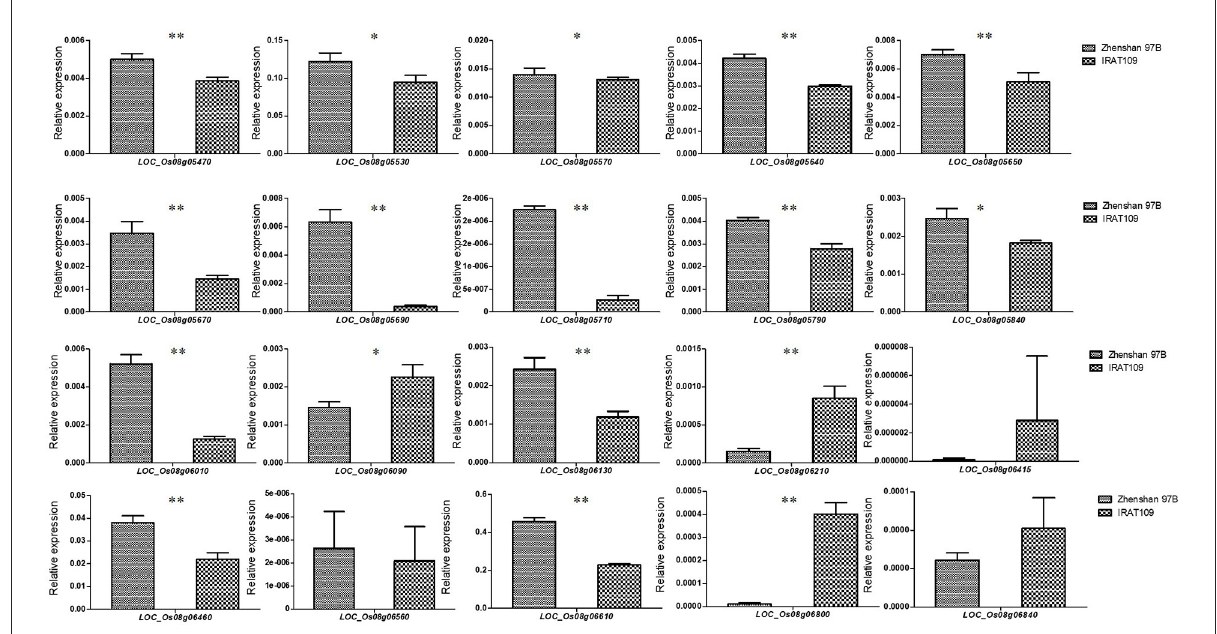
FIGURE2 The qRT-PCR analysis of the expression of candidate genes between Zhenshan 97B and IRAT109. * p < 0.05; ** p < 0.01; Student’s t -test. Values are the mean ± SD with three biological replicates.